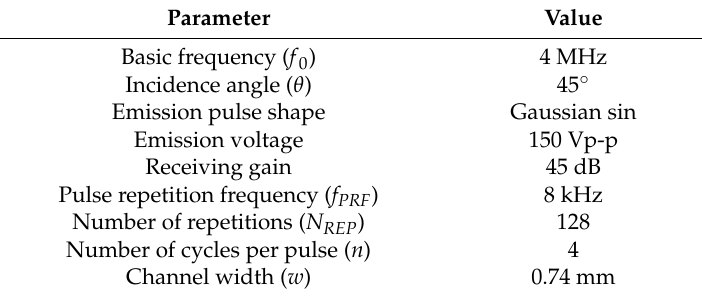
Table 5. Parameter configuration of UVP.